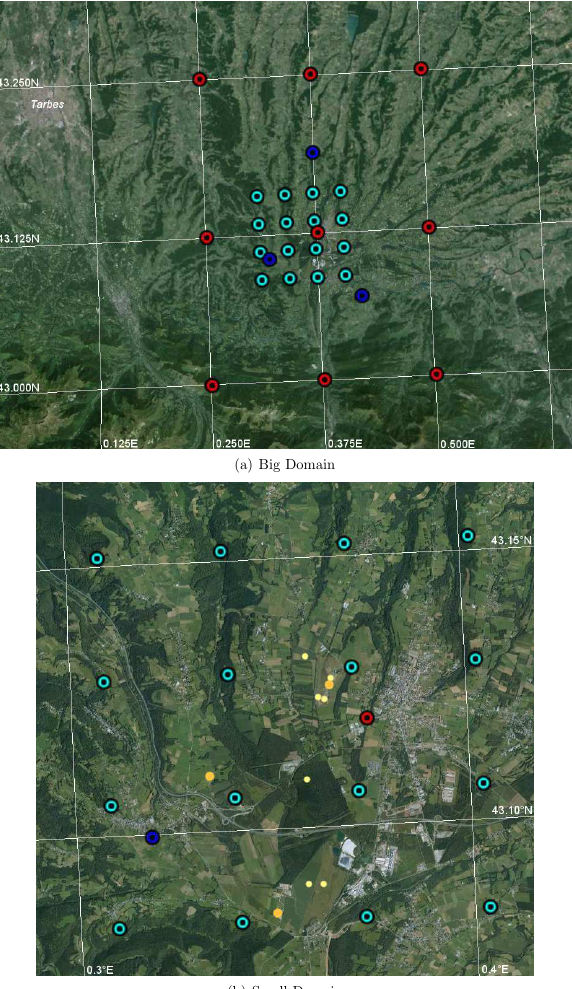
Figure 1. (a) Map of the different points extracted from the mod- els (red for ECMWF, blue for ARPEGE and cyan for AROME). (b) Zoom of (a) with surface sites shown by small yellow dots and radiosoundings’ launching site in large orange dots. Note that the westernmost site was the site for launching the few GRAW sound- ings that were not used in this study (Google Earth